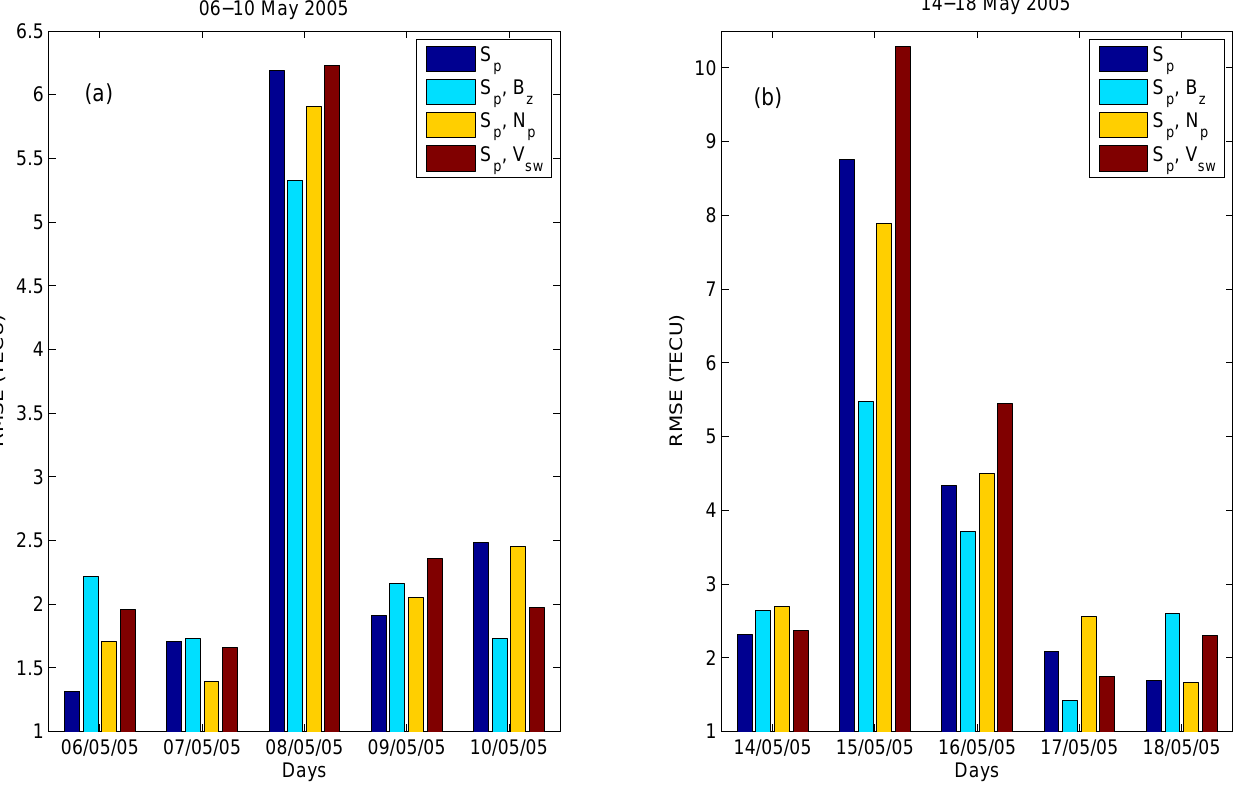
Fig. 9. Computed RMSE values between GPS TEC and the predicted TEC as a function of all combined parameters considered, for 6–10 and 14–18 May